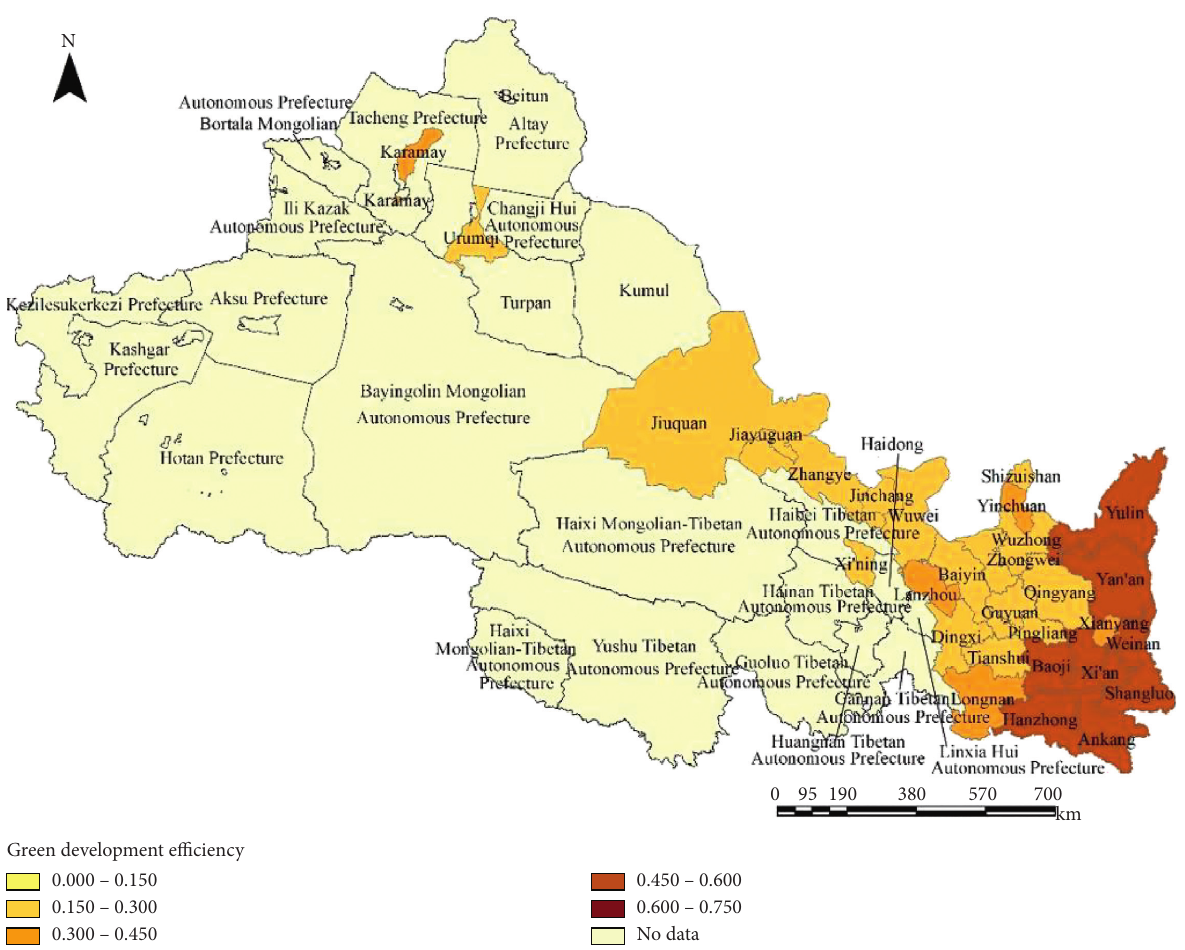
Figure 5: 2012 green development efficiency spatial map of prefecture-level cities in Northwest